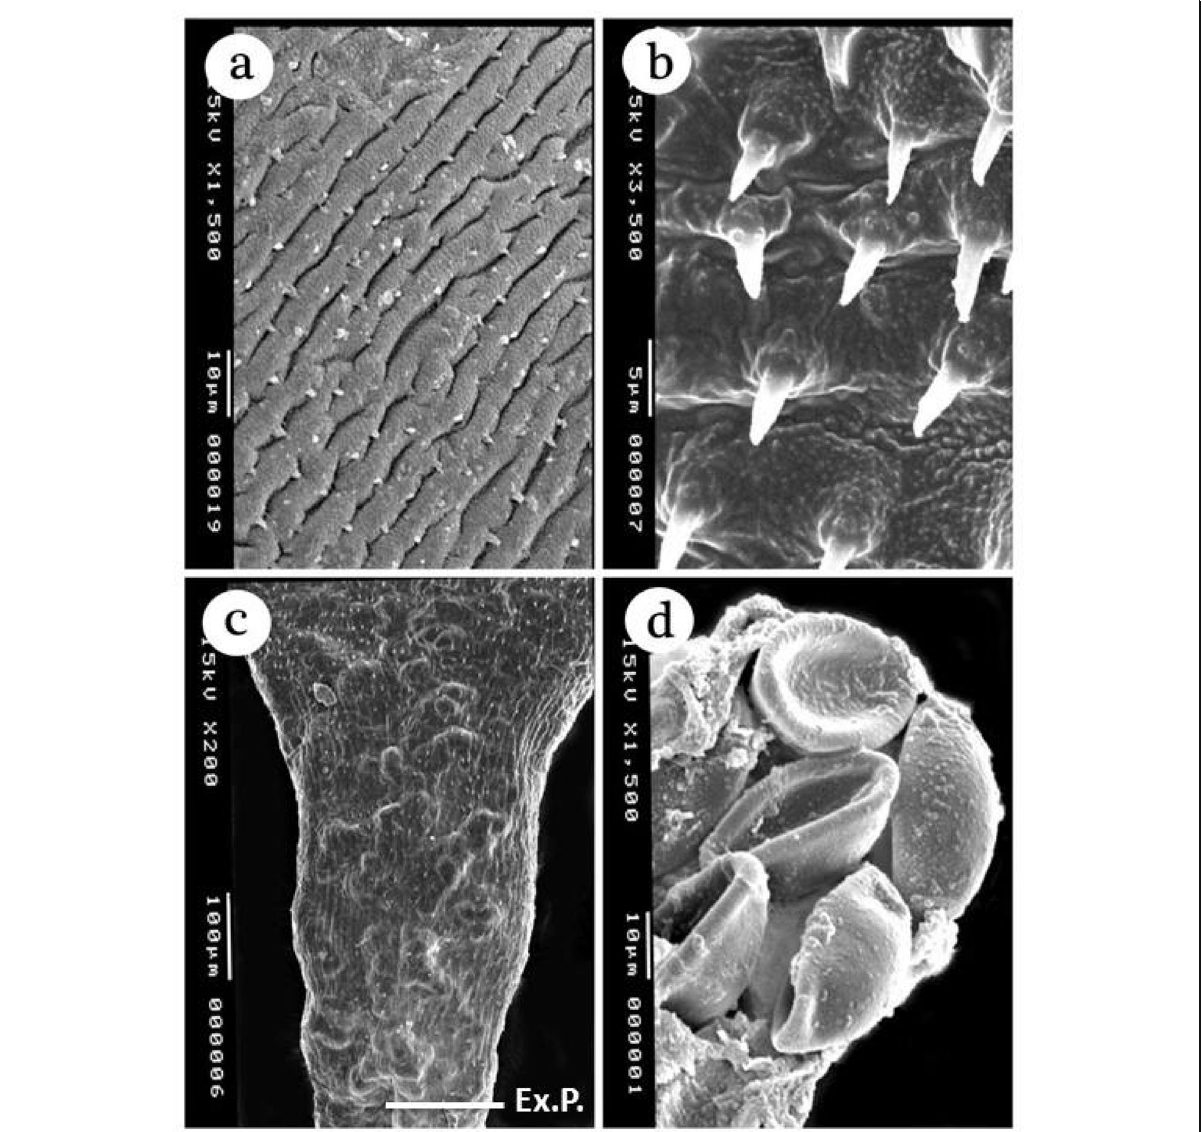
Fig. 5 Scanning electron micrographs of Mesocoelium sociale . a Shows the body surface wrinkles provided with spines. b Shows the tegument provided with curved distal-end spines arranged in transverse rows. c Shows the posterior part of the body with sparse tegumental spines, uterine coils filled with eggs, and terminate with an excretory pore (Ex.P.). d Shows the eggs with thick convex